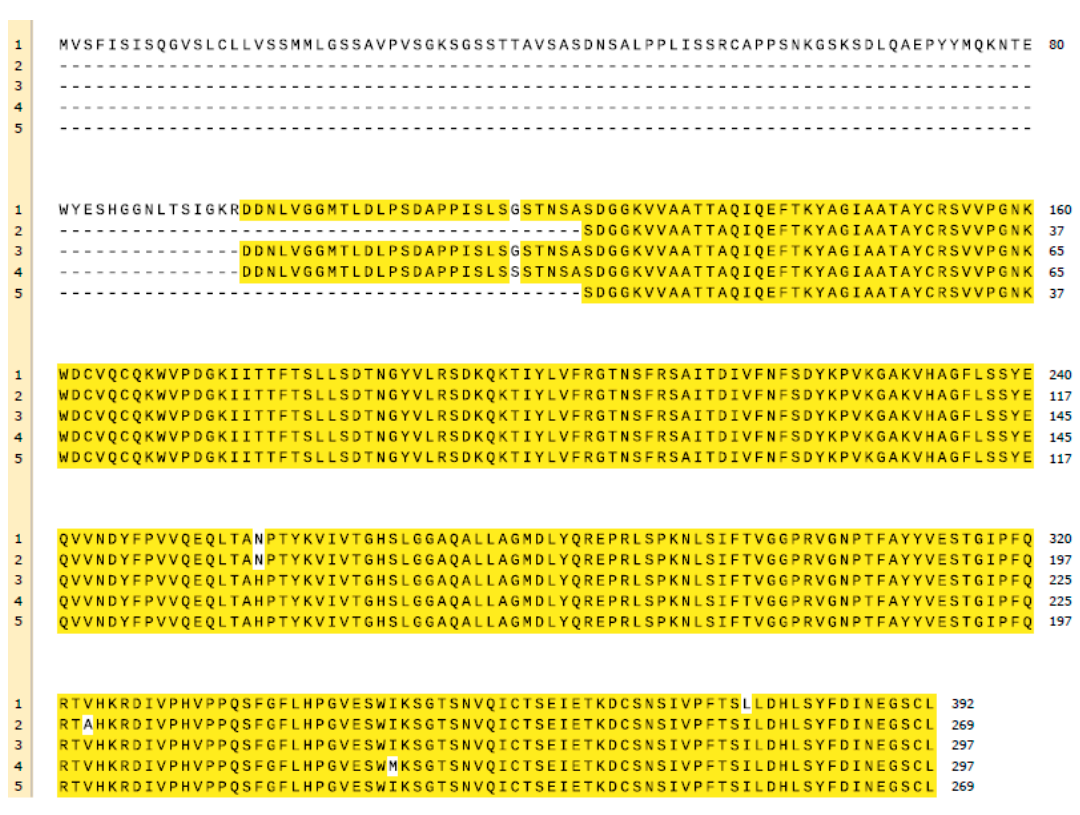
Figure 4. Multiple alignment of the sequences published by (1) Beer et al. (ROL) [56], (2) Ben Salah et al. (ROL) [57], (3) Sayari et al. (ROL) [58], (4) Khono et al. ( Rhizopus niveus lipase) [60] and (5) Derewenda et al. ( Rhizopus delemar lipase) [59]. Matching amino acids are highlighted in yellow, mismatching in white. BLAST from U.S. National Library of Medicine and Snapgene have been used for the creation of this figure.